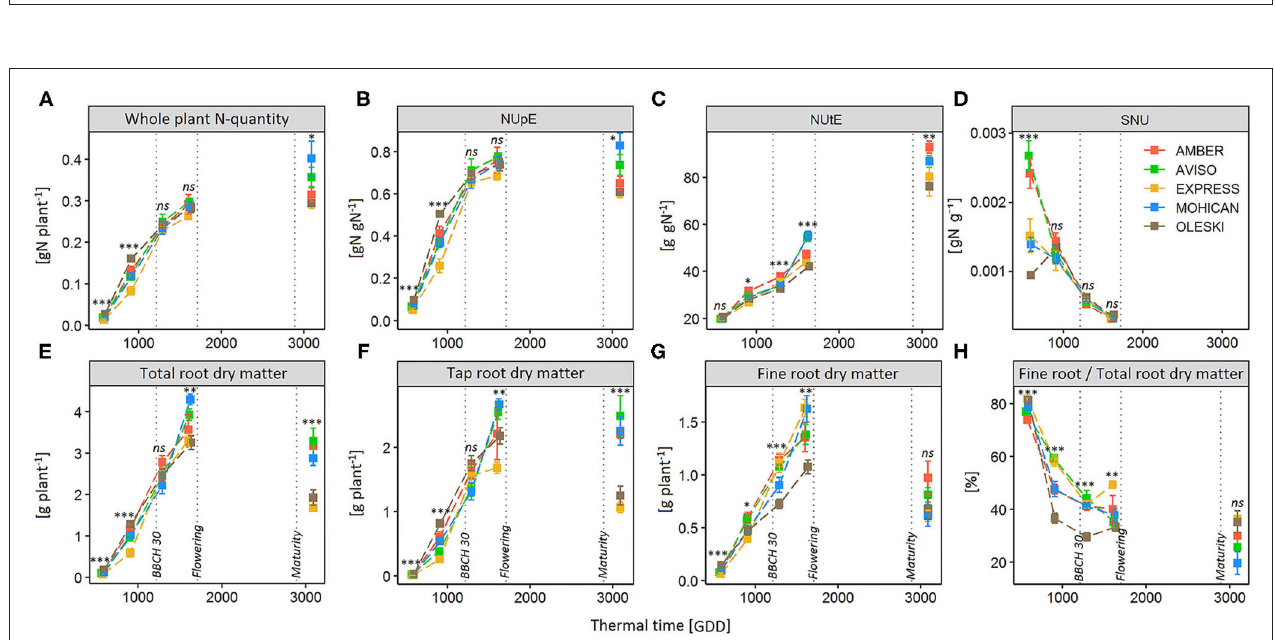
FIGURE 4 | Dynamics of N accumulation in the whole plant (A) , N Uptake Efficiency (NUpE) (B) , N Utilization efficiency (C) , Specific Nitrogen Uptake (SNU) (D) , total-root (E) , tap-root (F) and fine-root (G) dry matter, and fine-to total root ratio (H) during the crop cycle for five genotypes (AMBER, AVISO, EXPRESS, MOHICAN, OLESKI) grown under the low-N condition (GR18 experiment). Each genotype is represented by a different color. Vertical dotted lines depict the end of winter (BBCH 30), the beginning of flowering (BBCH 60), and the seed maturity (BBCH 84). Error bars indicate standard errors of the mean of each genotype, with n = 7–8 at each sampling date. Significance codes: *** P- value < 0.001, ** P- value < 0.01, * P- value < 0.05, ns, non-significant.